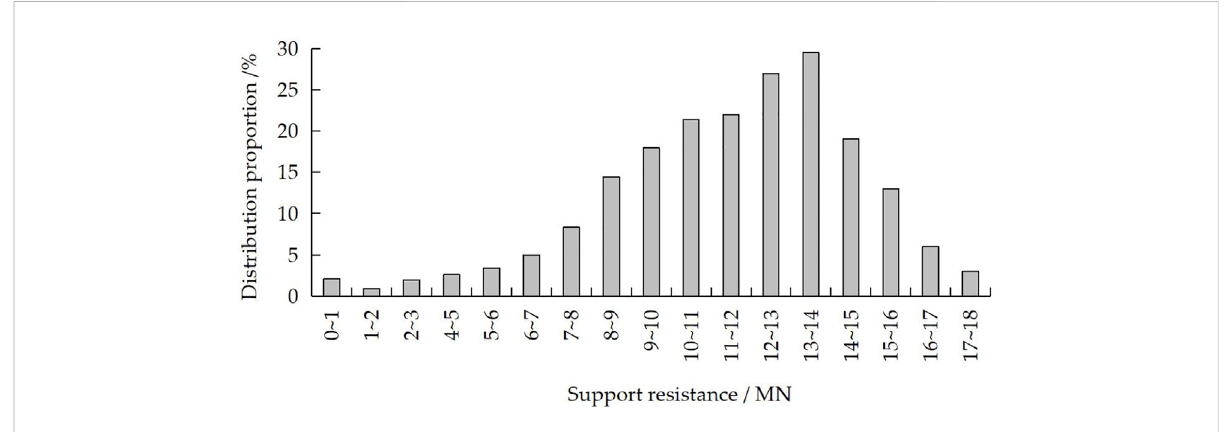
FIGURE 11 Support resistance distribution in a fully mechanized mining